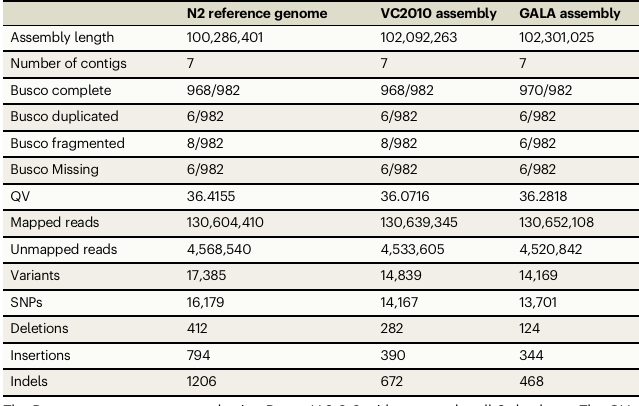
Table 1 | The assembly performance evaluation of GALA with Busco scores and statistics of alignment of Illumina short reads compared to the N2 reference genome 21 and the VC2010 assembly